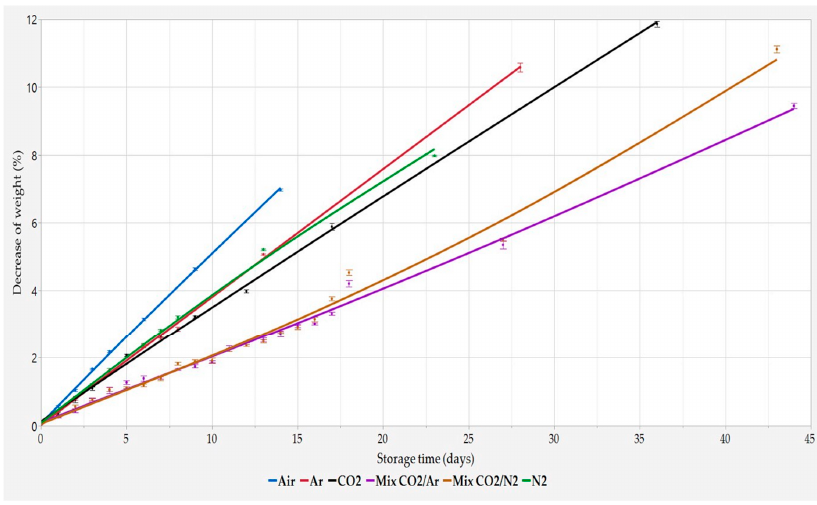
Figure 1. Percentage decrease in weight during storage time. Results are expressed as mean ± SD (n = 4).